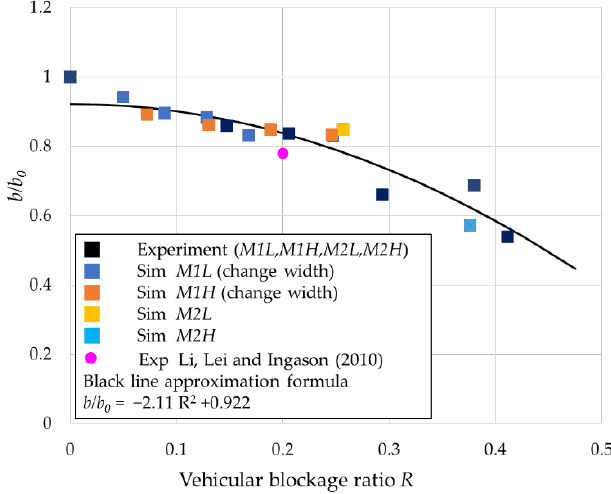
Figure 17. Approximation formula of b / b0 for Pattern A.